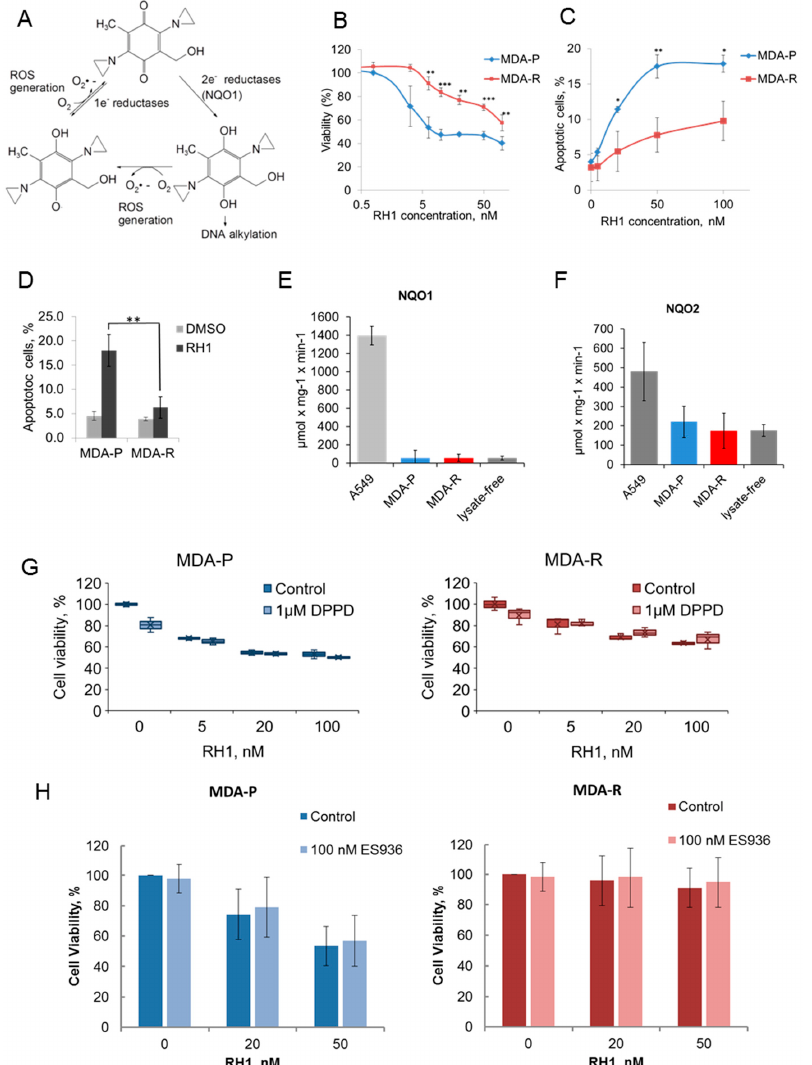
Figure 1. Characterization of RH1 resistant cells. ( A ). Molecular mechanism of the prodrug RH1 bioreduction. ( B ). Viability test. MDA-P and MDA-R cells were treated with increasing concentrations of RH1 for 2 h. Cell survival after 96 h was estimated by MTT assay. Bars are ± SD, significant di ff erences are marked by asterisks: ** p < 0.05, *** p < 0.01, t -test, n = 3. ( C ). Apoptosis assay. MDA-P and MDA-R cells were exposed to increasing concentrations of RH1 for 2 h and then cultured in drug-free medium for another 48 h. Apoptosis was assayed using acridine orange / ethidium bromide staining. Bars are ± SD, significant di ff erences are marked by asterisks: * p < 0.1, ** p < 0.05, t -test, n = 3. ( D ). Quantification of flow cytometric nexin-based apoptosis assay. Cells were untreated or treated with 50 nM RH1 for 2 h and stained with Guava Nexin reagent after 48 h. Bars are ± SD, significant di ff erence is marked by asterisks: ** p < 0.05, t -test, n = 3. ( E ). NQO1 activity assay. The initial rate